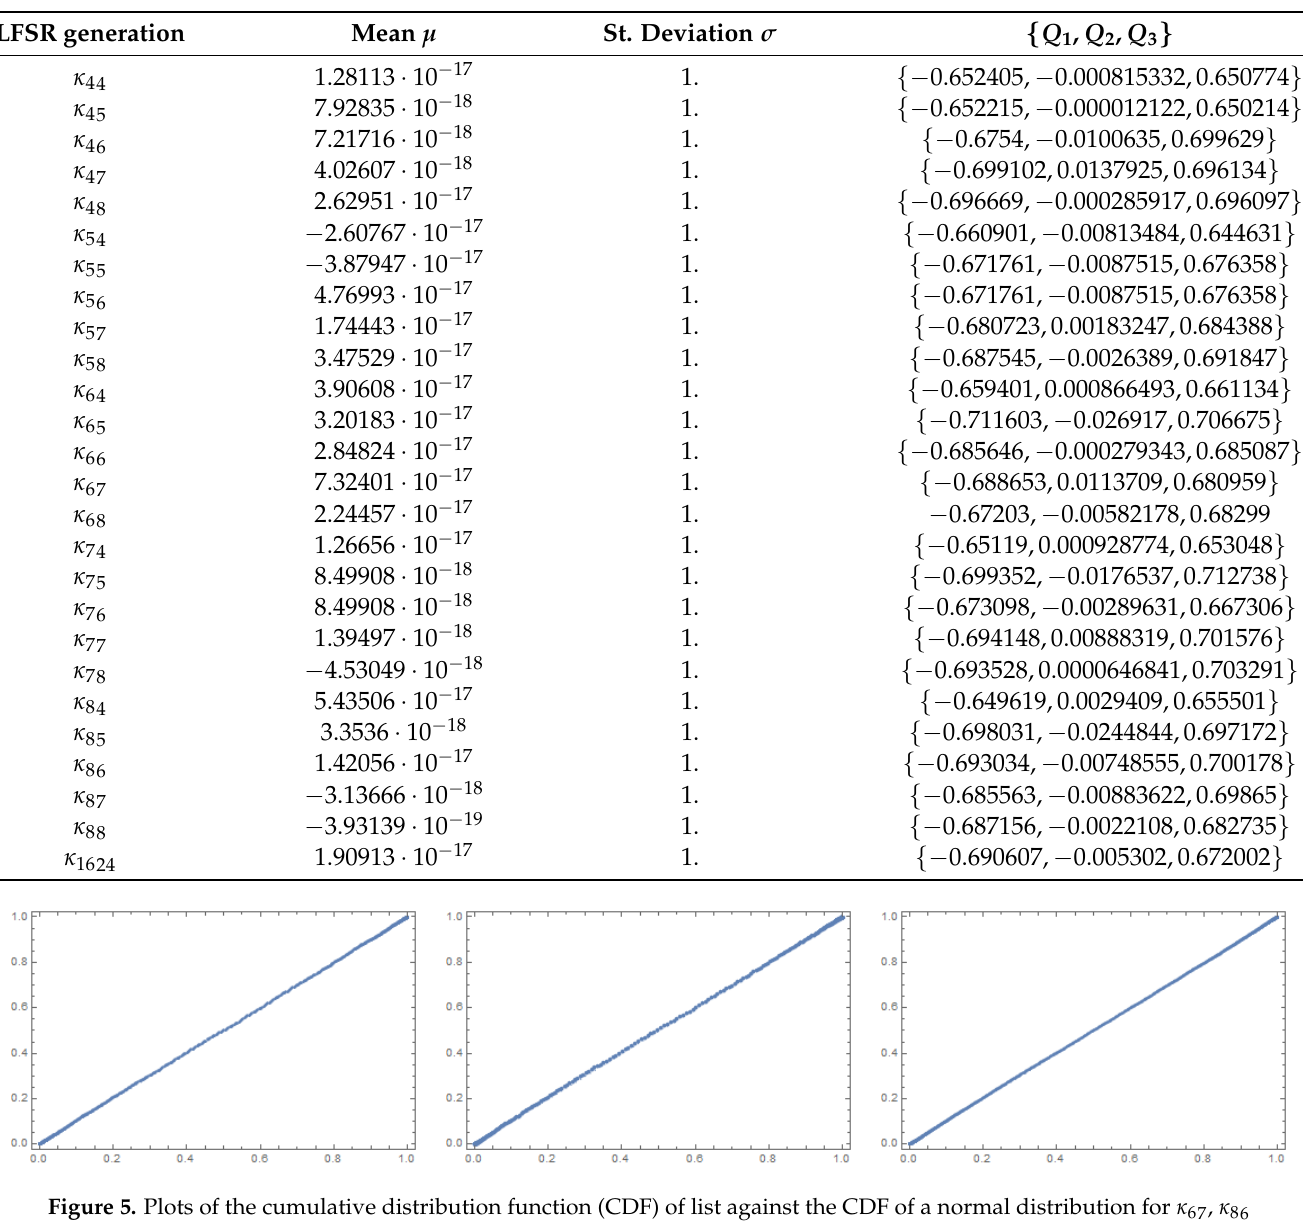
Table 5. Mean and standard deviation for the different polynomial over extended fields.